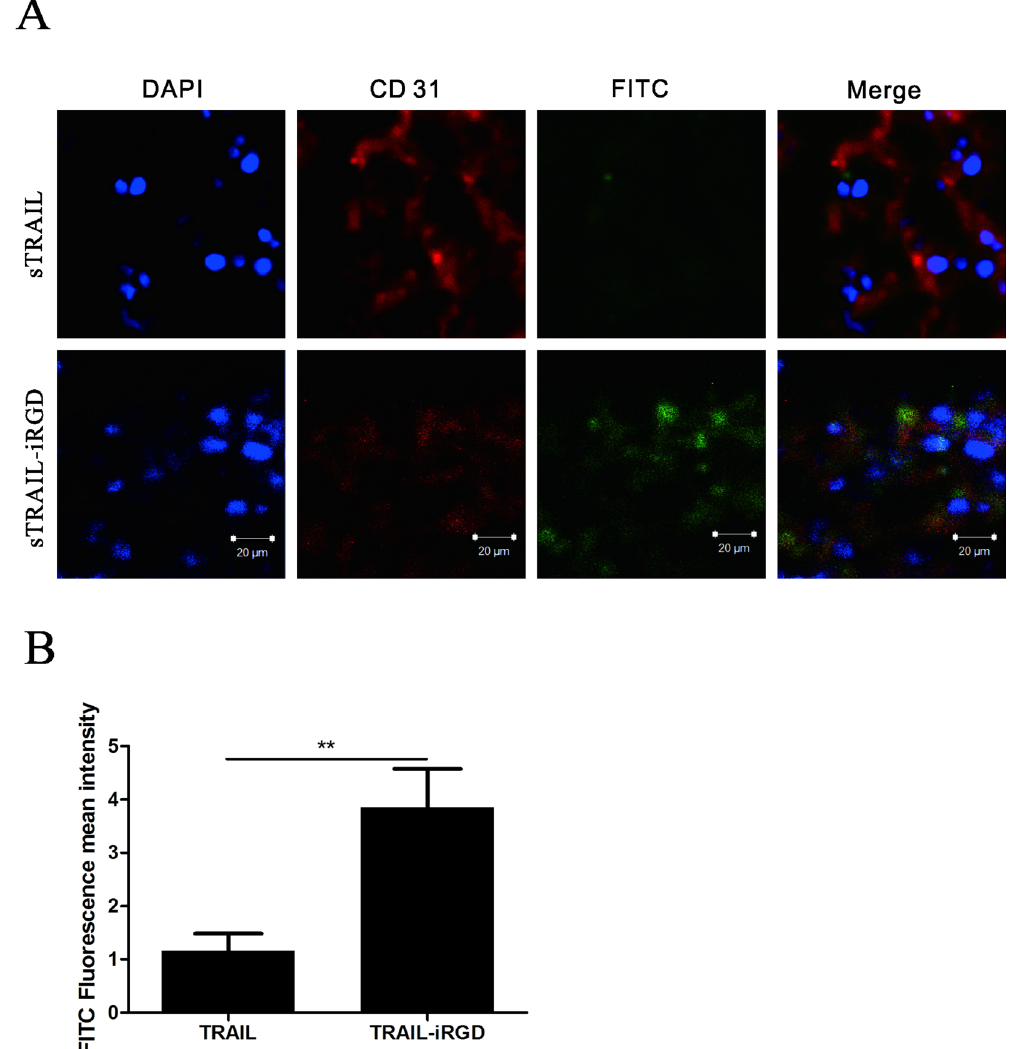
Figure 6. sTRAIL and sTRAIL-iRGD protein tumor penetration in MKN45 cell-injected mice 1 h post- injection. Frozen sections were examined under a confocal microscope. ( A ) Blood vessels were visualized with anti-CD31 (red), nuclei were stained with DAPI (blue), and green represents sTRAIL or sTRAIL-iRGD. Bars represent 20 μ m. Quantification of fluorescence intensity. ( B ) Error bars denote SD. ** p ≤